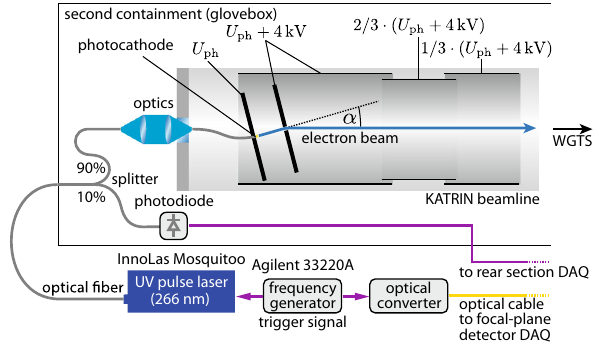
Fig. 2 A simplified schematic drawing of the electron gun, including the acceleration electrodes as well as the optical setup used to generate the photoelectrons